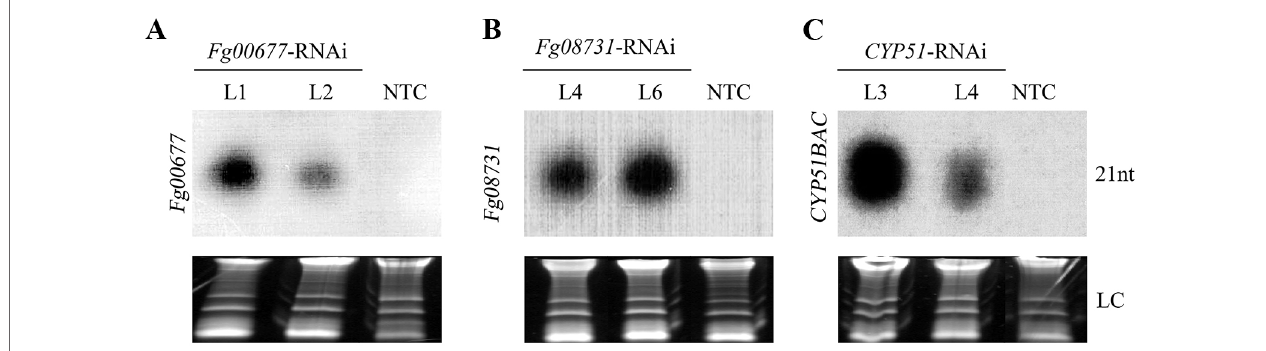
FIGURE 5 | siRNA detection in transgenic B. distachyon lines. Northern blot analysis of sequence-specific siRNA molecules derived from Fg00677 (a) , Fg08731 (B) , and CYP51BAC (C) RNAi fragments in the T2 transgenic B. distachyon lines with Fg00677 -RNAi, Fg08731 -RNAi, and CYP51 -RNAi constructs. Ethidium bromide-stained rRNA served as loading control (LC). NTC, non-transformed control.